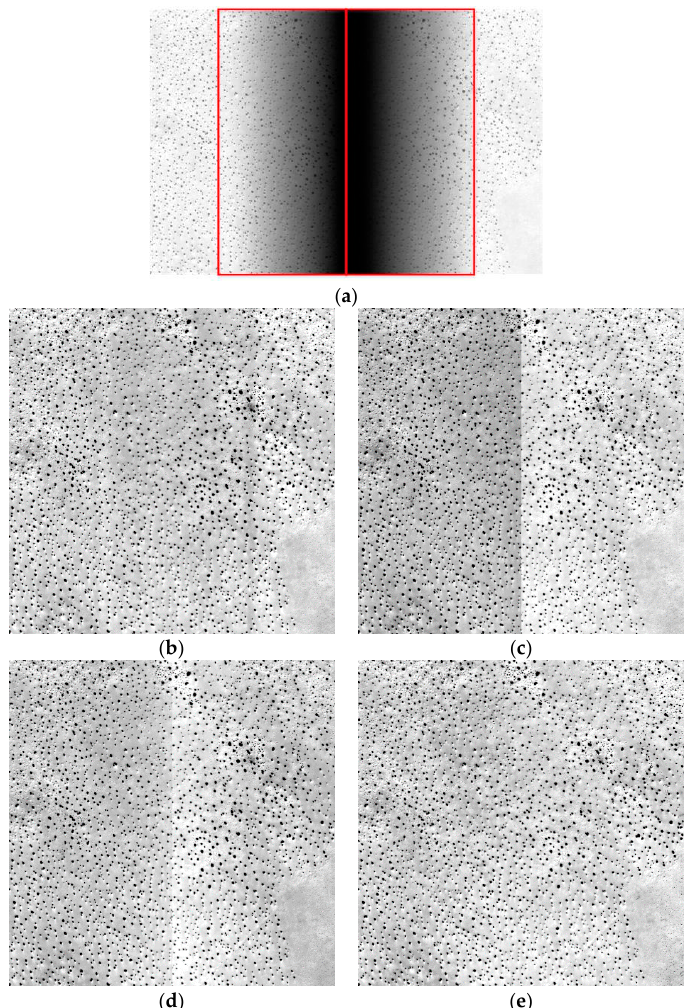
Figure 20. Raw and corrected images of the desert (the images were stretched for display): ( a ) raw image; ( b ) image corrected using the polynomial fitting; ( c ) image corrected using the laboratory coefficients; ( d ) image corrected using the on-orbit coefficients; ( e ) image corrected using the proposed method.